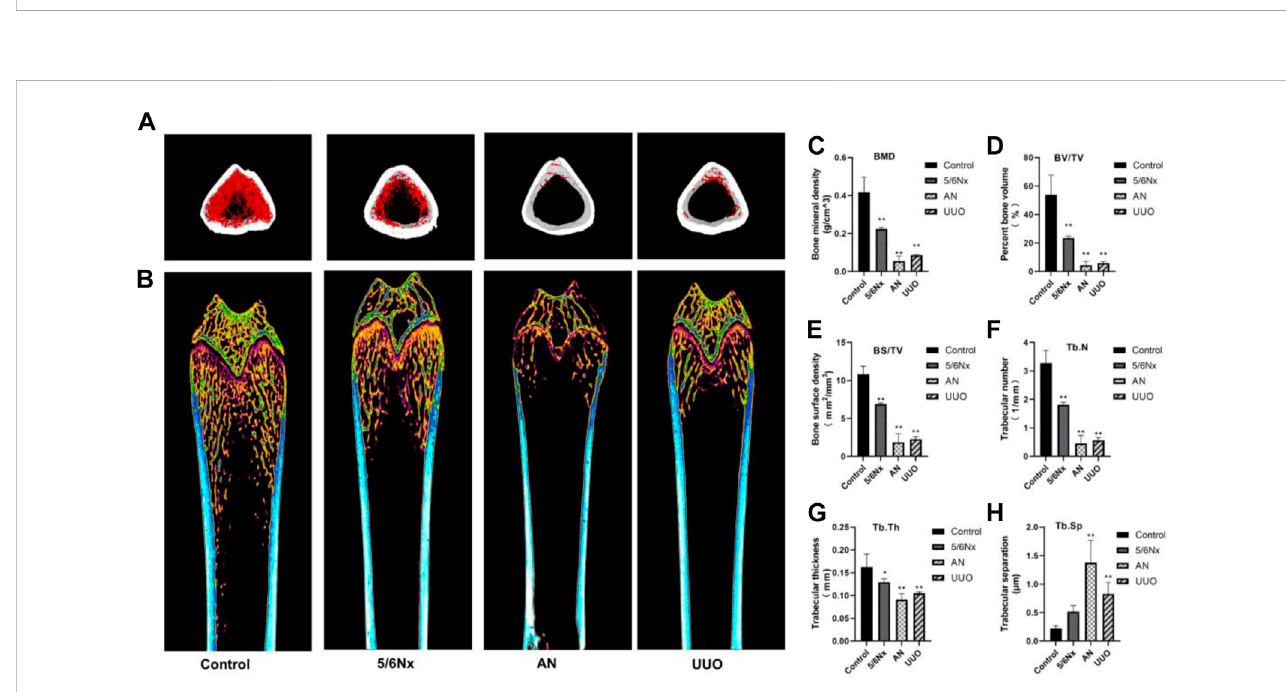
Image of femurs from different models. (A, B) Representative micro-CT 3D reconstruction images of femurs from the three model groups. (C – H) Parameters of bone histomorphometry. * p < 0.05 and ** p < 0.01 vs. the control group. Data are presented as mean ± SD. n =